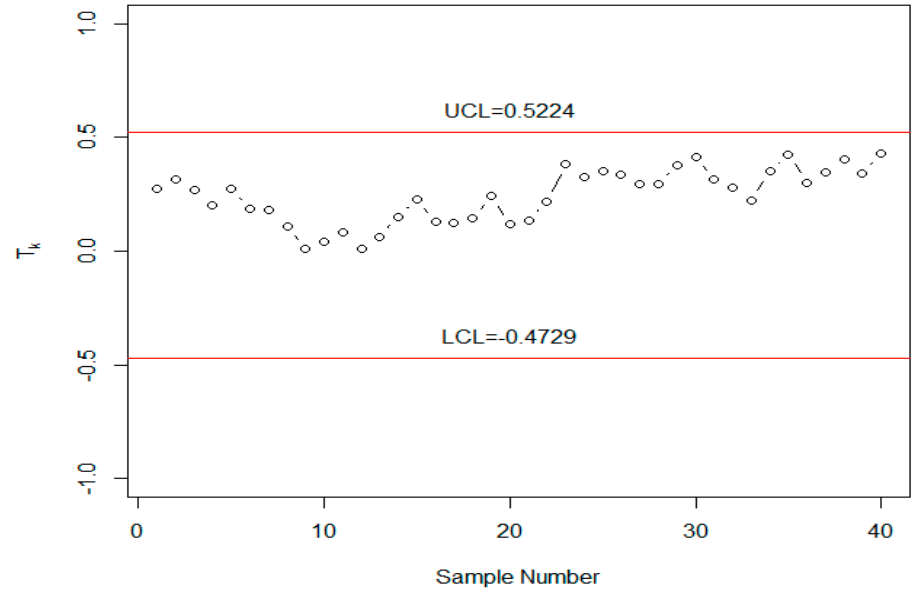
Figure 2. The control chart proposed by Reference [38] for simulated data.